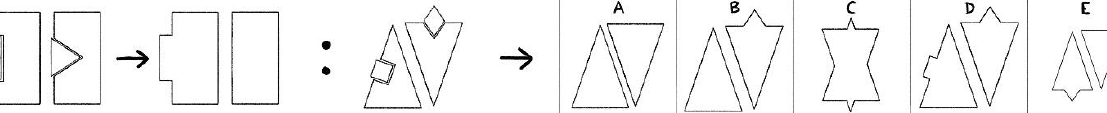
Figure 1. Figural analogy example. Note. An example figural analogy item used in the current study. The answer to this item is B.